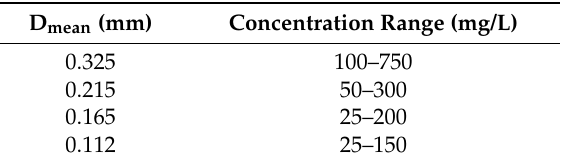
Table 3. Sizes and concentrations tested using natural beach sand from Folly Beach, South Carolina, sieved to yield well-sorted fractions. Experimental apparatus was the same as with the construction